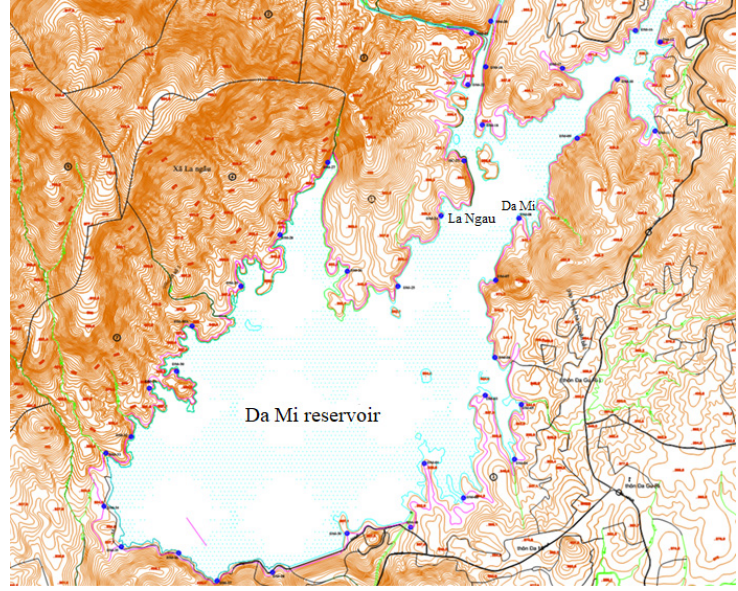
Figure 4. Topography of Da Mi hydropower reservoir area.